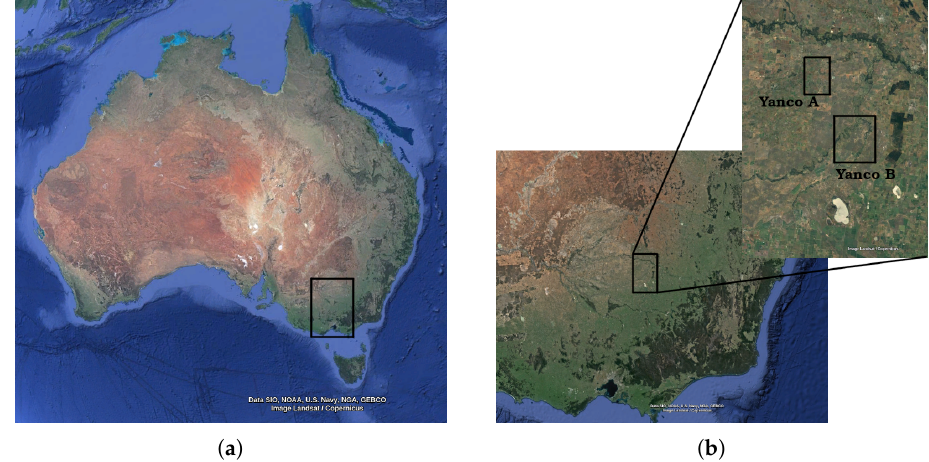
Figure 1. ( a ) Highlighted in black is the NSW area of Australia where the flight was conducted, and ( b ) definition of the Yanco areas A (34 ◦ 43 (cid:48) S, 146 ◦ 05 (cid:48) E) and B (34 ◦ 59 (cid:48) S, 146 ◦ 18 (cid:48)